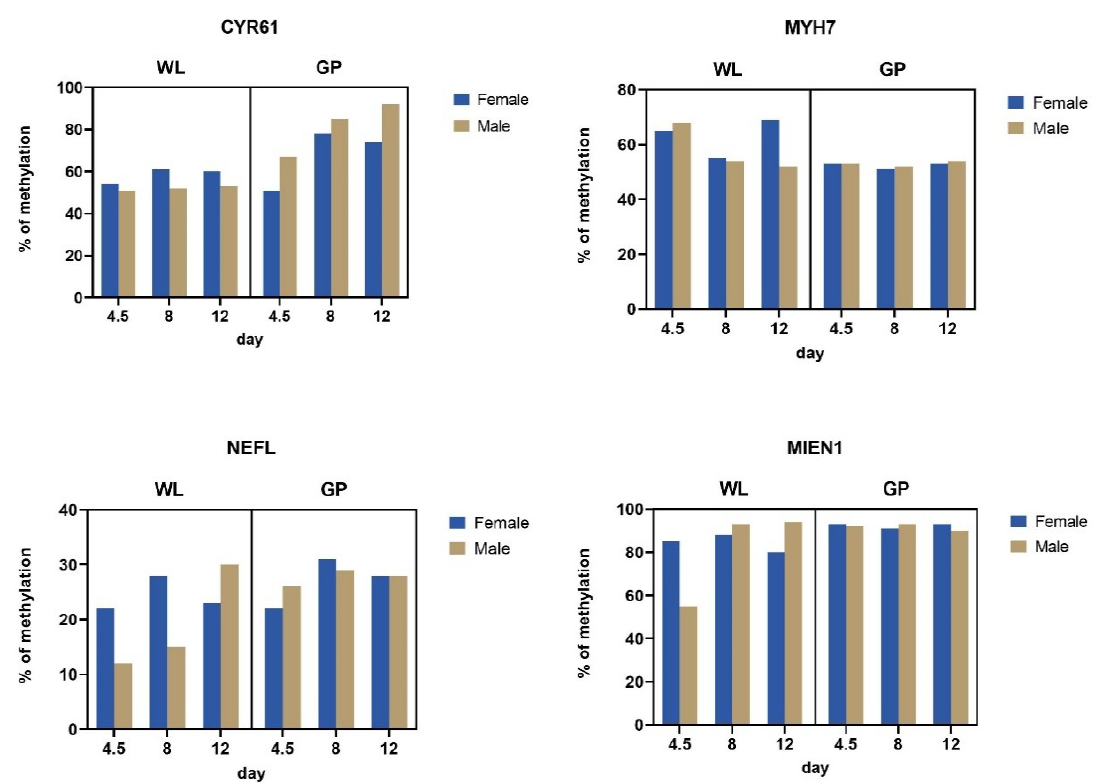
Figure 6. DNA methylation of the CYR61, MYH7, NEFL , and MIEN1 genes in gonadal PGCs of WL and GP in three stages of embryonic development (days 4.5, 8, and 12) and categorized by sex. X -axis: days of embryonic development on which PGCs are collected; Y -axis: percentage of gene methylation.